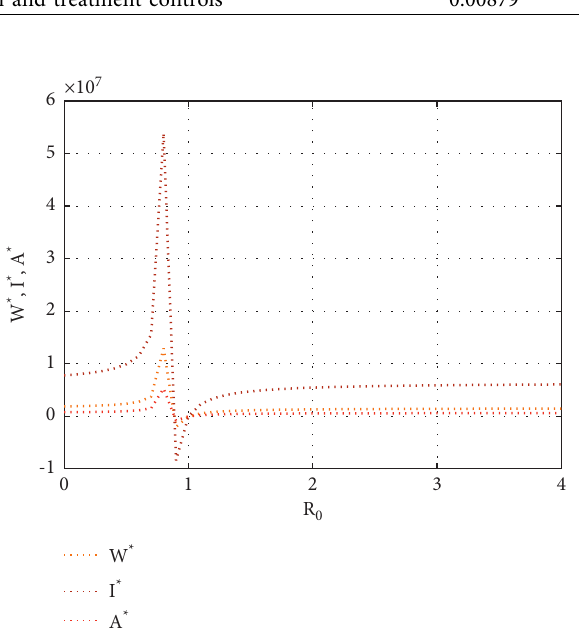
Figure 2: The simulations of HIV-infected populations versus the reproduction